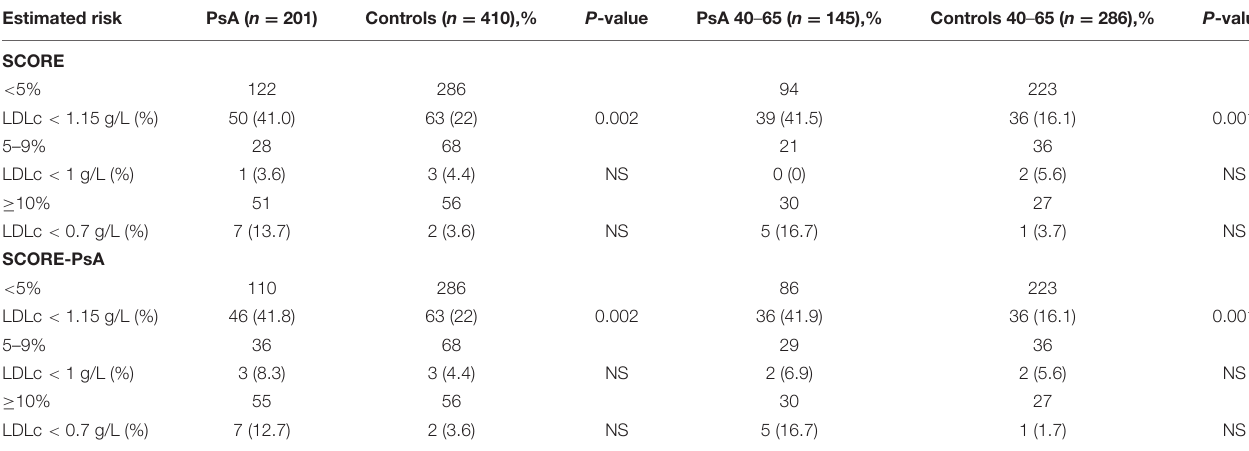
TABLE 5 | Percentage of patients with PsA at LDLc target according to EU recommendations with SCORE equations. Estimated